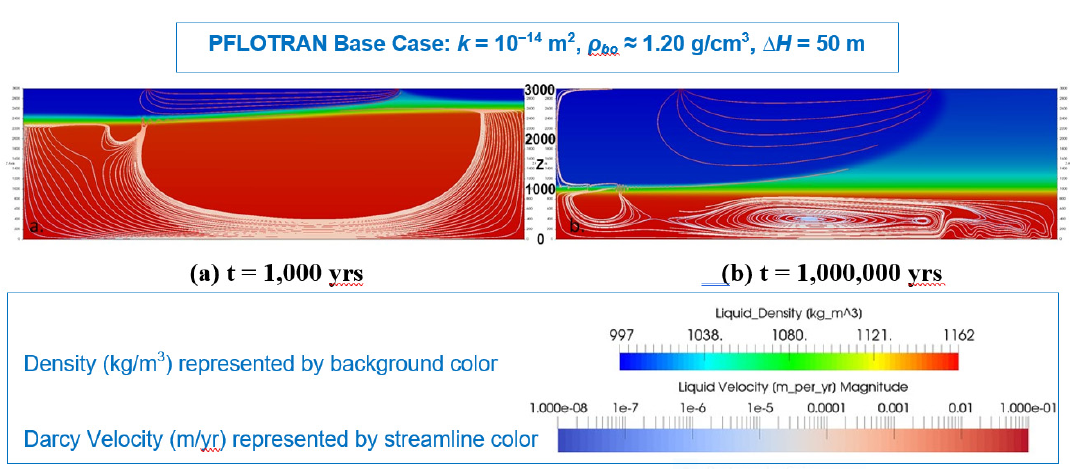
Figure 3. PFLOTRAN Base Case (k = 10 − 14 m 2 ) Model Results (Fluid Density and Darcy Flux) ( a ) at 1,000 years and ( b ) 1,000,000 years.